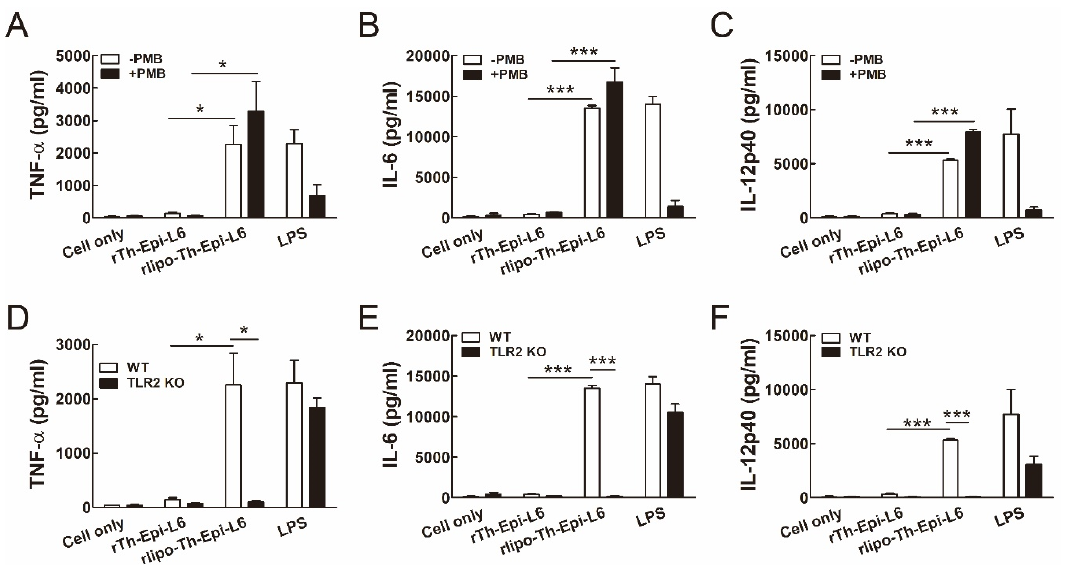
Figure 3. rLipo-Th-Epi-L6 stimulates bone marrow-derived dendritic cells (BM-DCs) to secrete Figure 3. rLipo ‐ Th ‐ Epi ‐ L6 stimulates bone marrow ‐ derived dendritic cells (BM ‐ DCs) to secrete cytokines. ( A – C ) Cytokine TNF- α ( A ), IL-6 ( B ), and IL-12p40 ( C ) secretion by DCs was stimulated by cytokines. ( A – C ) Cytokine TNF ‐α ( A ), IL ‐ 6 ( B ), and IL ‐ 12p40 ( C ) secretion by DCs was stimulated by rlipo-Th-Epi-L6. BM-DCs were cultured with rTh-Epi-L6 (50 nM), rlipo-Th-Epi-L6 (50 nM), or LPS rlipo ‐ Th ‐ Epi ‐ L6. BM ‐ DCs were cultured with rTh ‐ Epi ‐ L6 (50 nM), rlipo ‐ Th ‐ Epi ‐ L6 (50 nM), or LPS (0.1 µ g / mL) in the presence or absence of polymyxin B (PMB; 30 µ g / mL). After a 24-h (0.1 μ g/mL) in the presence or absence of polymyxin B (PMB; 30 μ g/mL). After a 24 ‐ h incubation, the